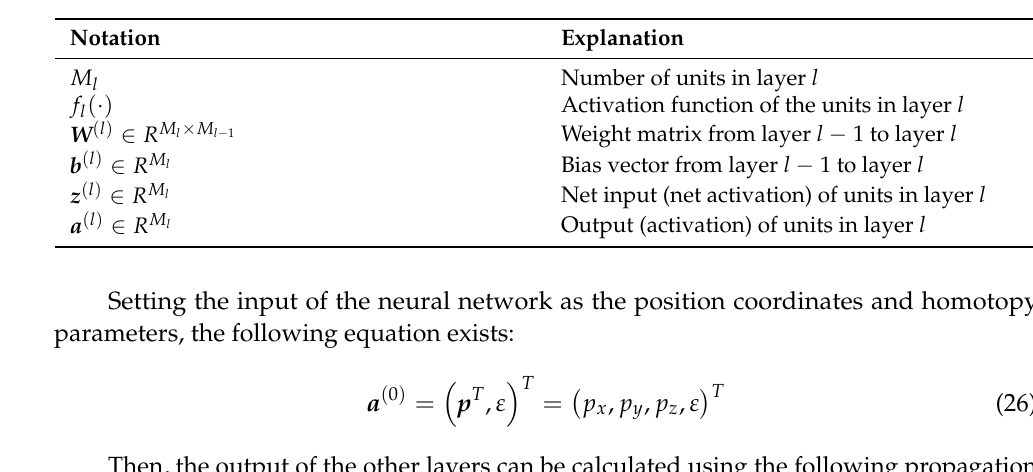
Table 2. The meaning of the associated notation.